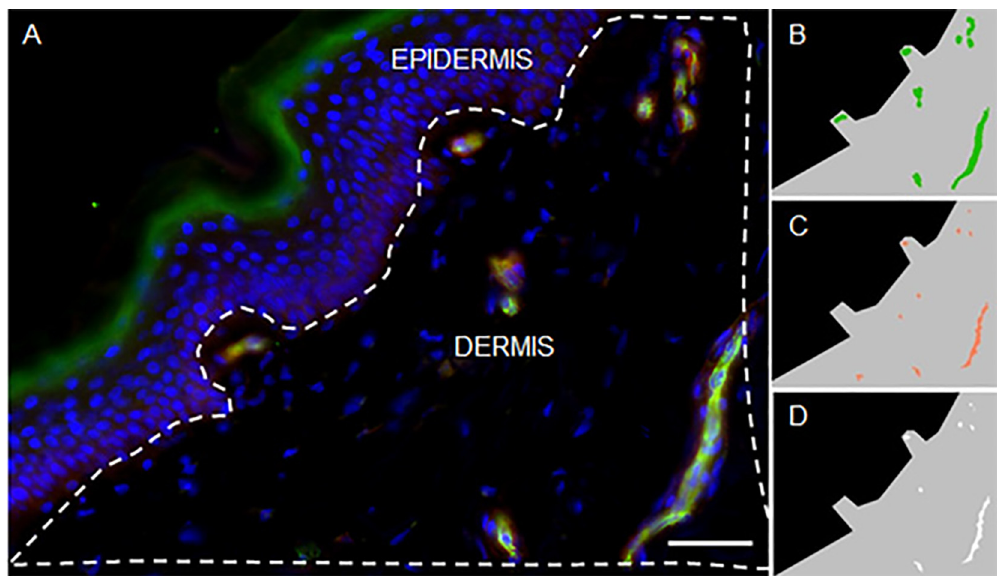
Fig 2. Definiens 1 analysis of NRP-1 expression in dermis. (A) NRP-1 (red)/CD31 (green) double labeling immunofluorescence in the dermis of human skin biopsy. Dashed line represents the delineation of the ROI in dermis. (B) NRP-1 (green) immunoreactivity subtracted by Definiens 1 technology in delineated ROI (grey). (C) CD31 (orange) immunoreactivity subtracted by Definiens 1 technology in delineated ROI (grey). (D) NRP-1/CD31 double staining (white) subtracted by Definiens 1 technology in delineated ROI (grey). Scalebar: 50 μ m.